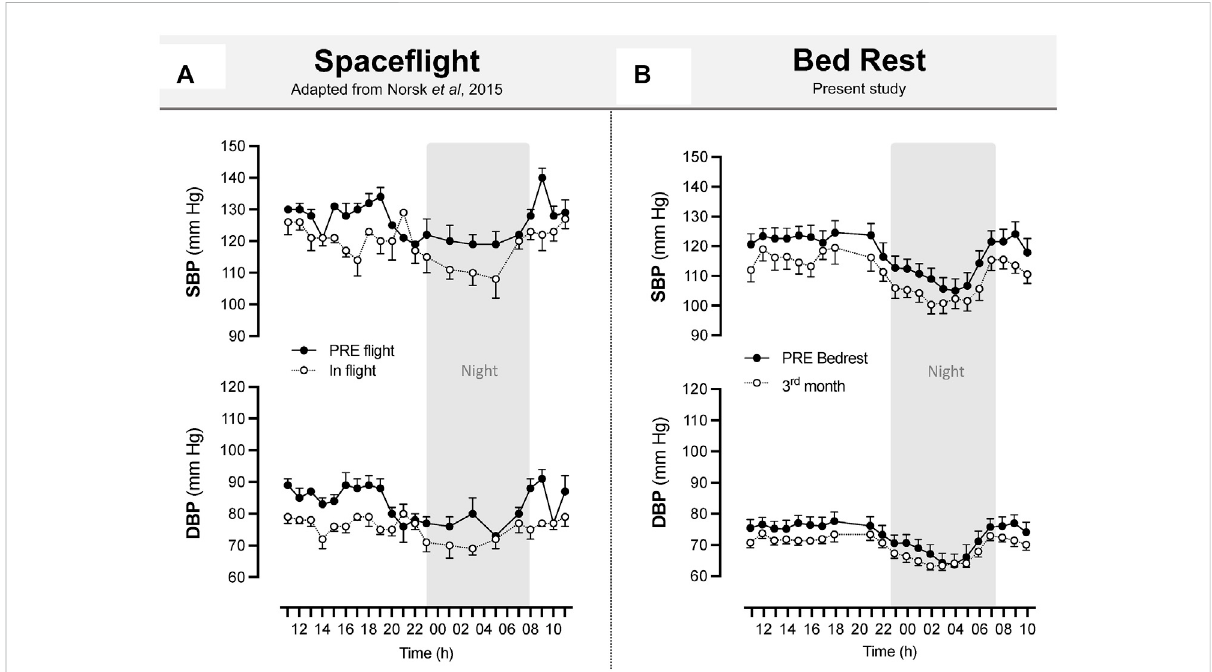
FIGURE 11 Space fl ight and long-term bedrest similarly induced a decrease in systolic and diastolic blood pressure. Systolic and diastolic blood pressure during space fl ight (A) . Upper arm artery blood pressure was measured between 85 and 192 days of fl ight. Recordings are hourly during the day and bihourly during the night over 11:00 – 11:00. The sample size was n = 8, and data are presented as the mean ± SEM. Adapted from Norsk et al., 2015 . Systolicanddiastolicbloodpressureduring90-daybedrest (B) estimatedfromPulseTransitTimeusingtheSOMNOtouch ™ device.Recordings are beat by beat over 21:00 – 18:00. The sample size was n = 8 (CON), and data are presented as the mean ± SEM from the present